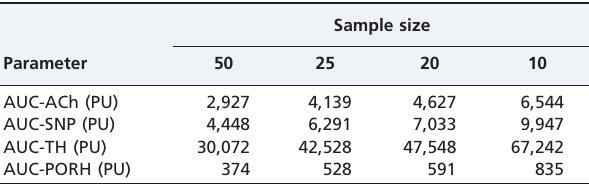
Table 3 - Estimates of the minimum differences expected to be statistically significant according to the sample size under different conditions of microvascular reactivity in longitudinal studies using laser Doppler perfusion